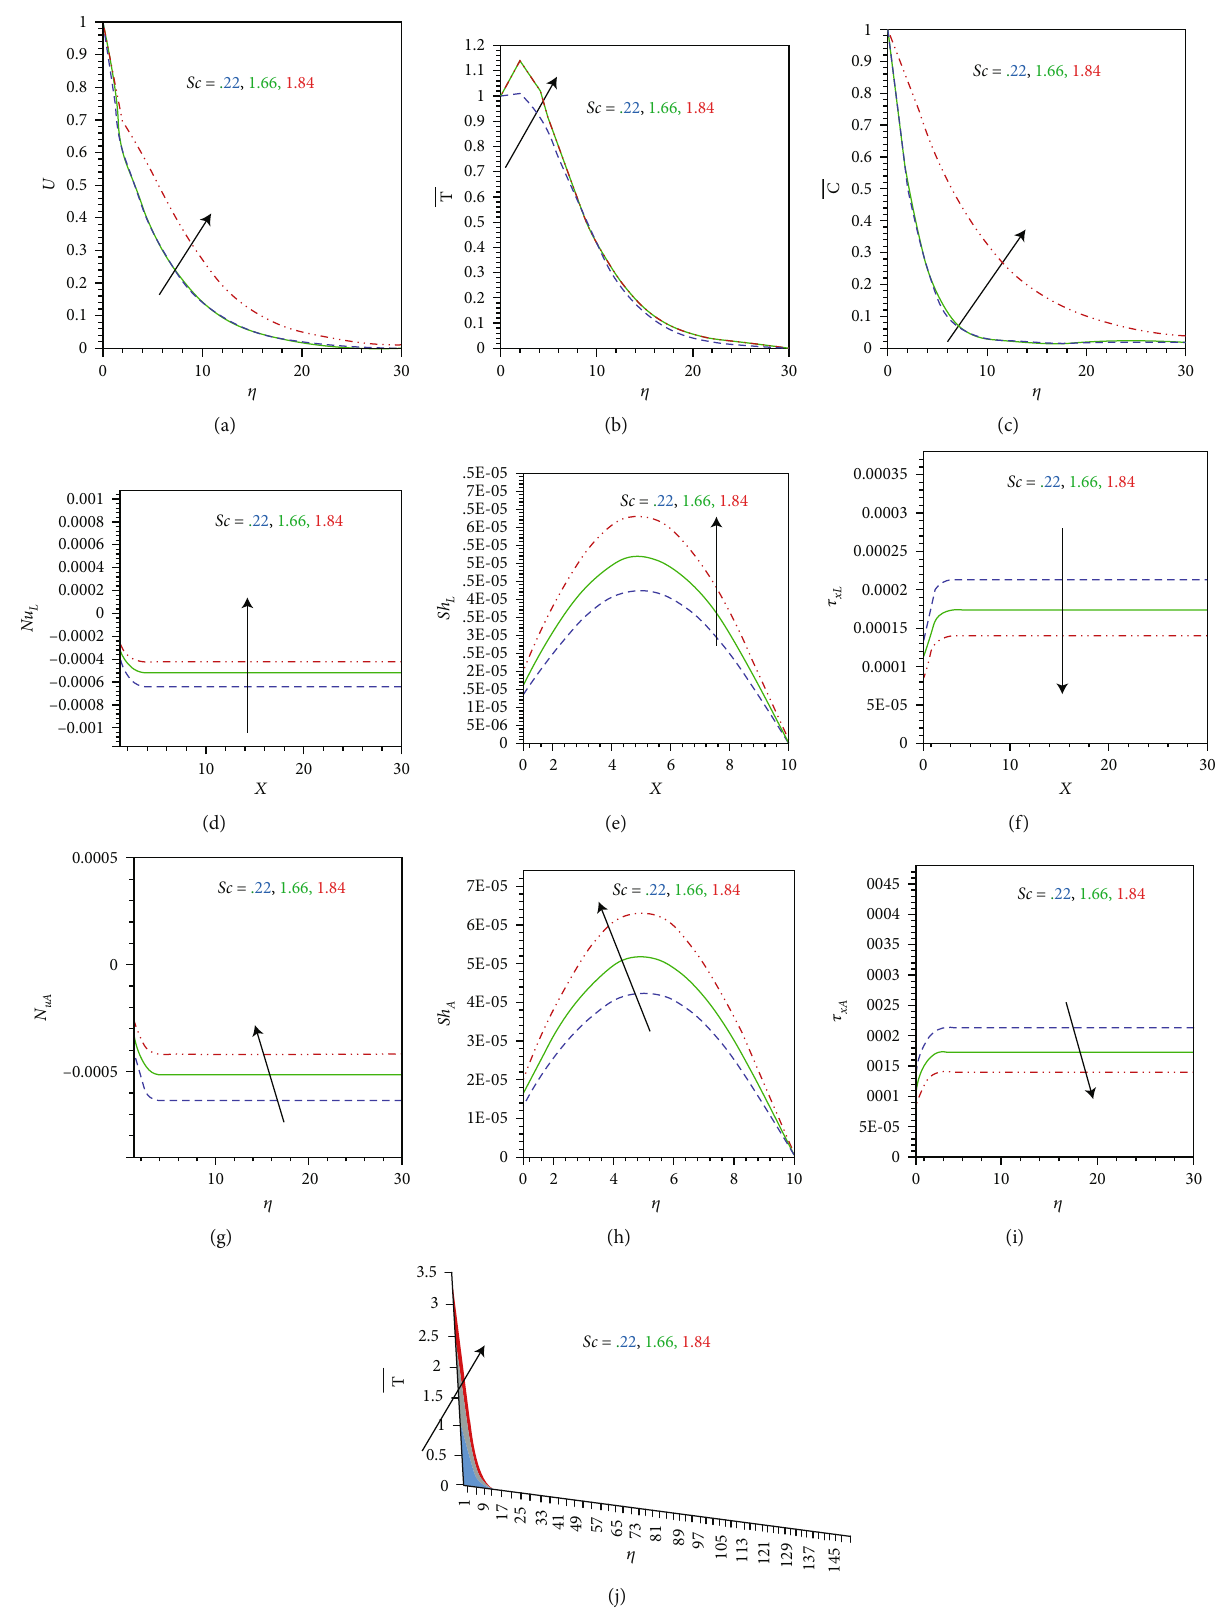
Figure 11: In fl uence of Schmidt number on (a) fl ow, (b) thermal, (c) material fi elds, (d) Nu and (j) thermal fi elds in the 3D plot with M = 9 : 5 , Gr = 3 : 5 , Gm = 4 : 5 , Pr = 1 , Ec = 0 : 1 , N = 1 , R = 1 , and H = 0 : 3